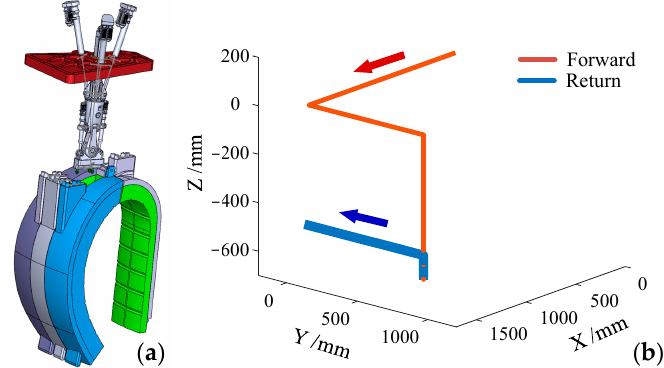
Figure 4. Left outboard BB position ( a ); lifting left outboard BB trajectory ( b ).